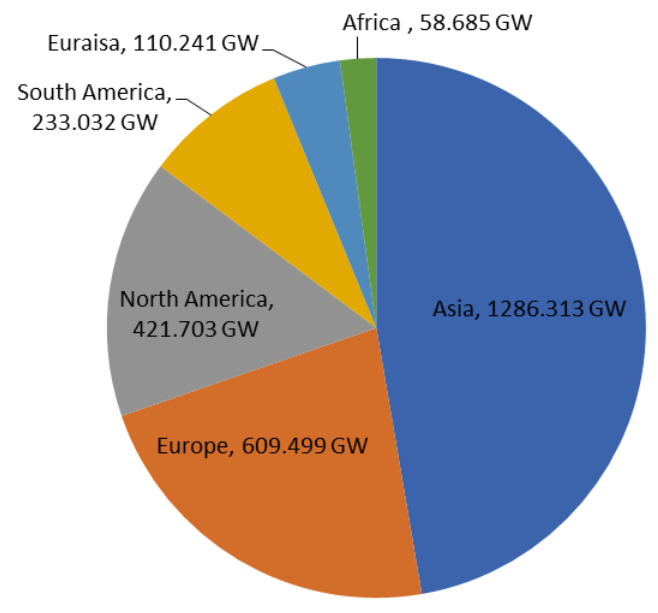
Figure 1. Trends in renewable energy by region [4].